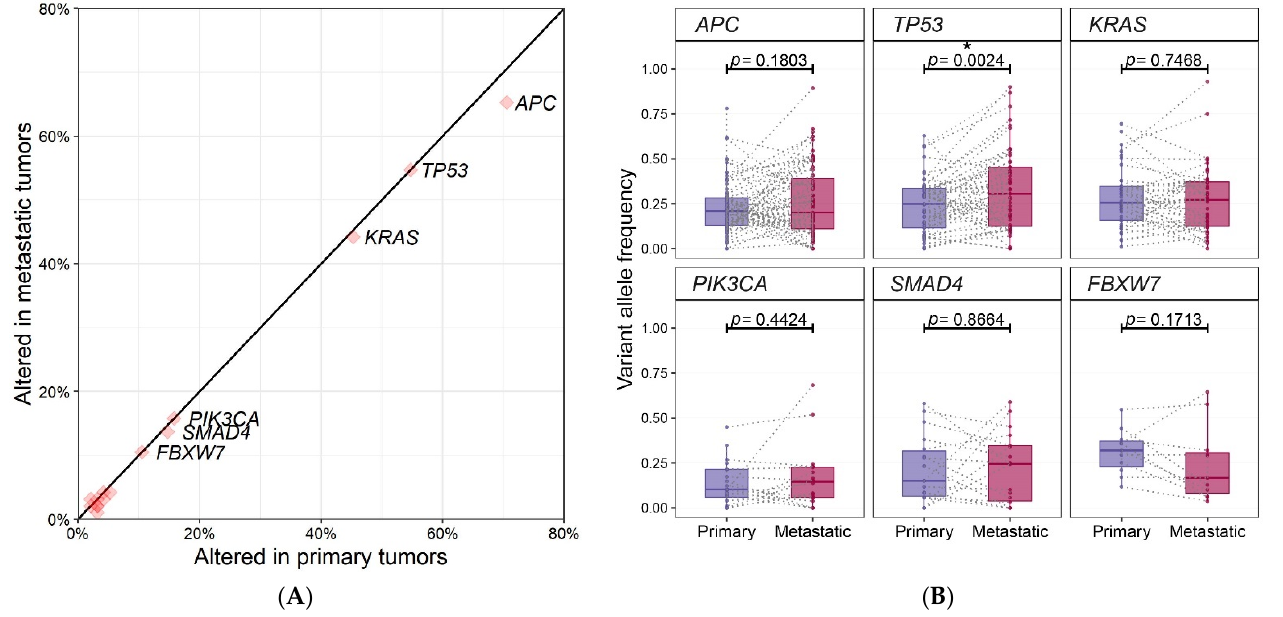
Figure 2. ( A ) Comparison of mutational frequencies between 95 pairs of primary and metastatic tumors. It is the proportion of patients with mutations in the gene. Top six genes are annotated. ( B ) Comparison of variant allele frequencies of top six genes between 95 pairs of primary and metastatic tumors. Boxplots show the distribution of VAFs in each group and dots connected by dashed-lines represent same patients. Statistical significance is based on paired two sample t -test and p < 0.05 is marked with asterisk (*).